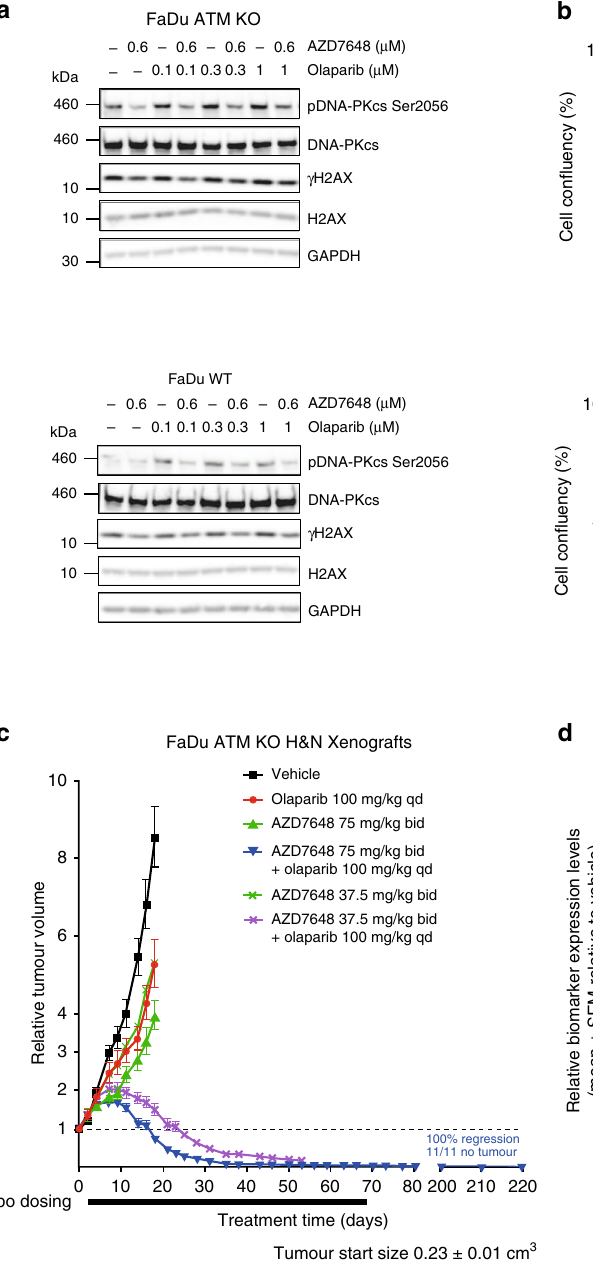
Fig. 5 AZD7648 and olaparib combination has antiproliferative ef fi cacy. a Western blot analysis of whole-cell lysates from FaDu WT or ATM KO cells treated with AZD7648 (0.6 μ M), olaparib (0.1, 0.3 or 1 μ M) or the combination for 24 hours. Both cell lines were run on the same blot. b Cell con fl uency of FaDu ATM KO and WT cells treated with AZD7648, olaparib or their combination. Graphs represent mean percentage cell con fl uency from a representative experiment ( n = 4). Percentage values indicate fi nal cell con fl uency at the indicated time point. c AZD7648 induces complete tumour regression in combination with olaparib in FaDu ATM KO xenografts (SCID mice, vehicle n = 6, olaparib n = 10, AZD7648 37.5 and 75 mg kg − 1 single agent and combination at 37.5 mg kg − 1 n = 8, combination at 75 mg kg − 1 n = 11, geometric mean ± SEM). Corresponding mouse bodyweights and statistical analysis can be found in Supplementary Fig. 2E and Supplementary Table 3C. To assess tumour growth inhibition, one-tailed, two-sample, t -test with unequal variances was used and for tumour regression, one-sample t -test analysis. d Pharmacokinetics of AZD7648 and pharmacodynamic modulation of DNA-PK biomarkers after dosing of AZD7648 and olaparib in FaDu ATM KO xenografts. Mice were taken from the ef fi cacy study described above ( c ) between days 11 and 18, and samples were collected 2 h after the fi rst dose of AZD7648 (1 h after the dose of olaparib). Measured by western blotting (SCID mice, vehicle n = 10, olaparib n = 11, AZD7648 n = 12, combination n = 3, mean ± SEM). Signi fi cance assessed with two-sided t -tests performed on log-transformed data assuming unequal